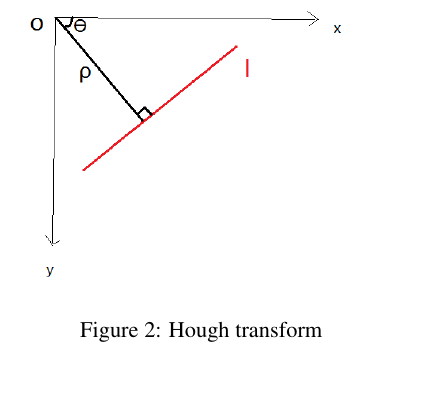
Figure 2: Hough transform